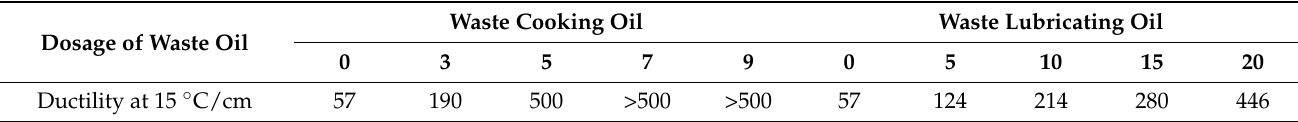
Table 9. Influence of different waste oil on ductility of aged asphalt